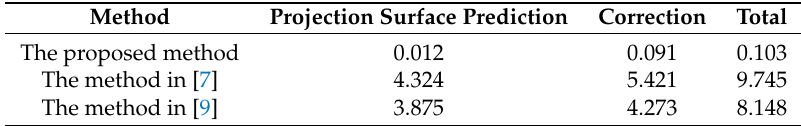
Table 4. The correction time (seconds) results of the proposed method and existing methods.